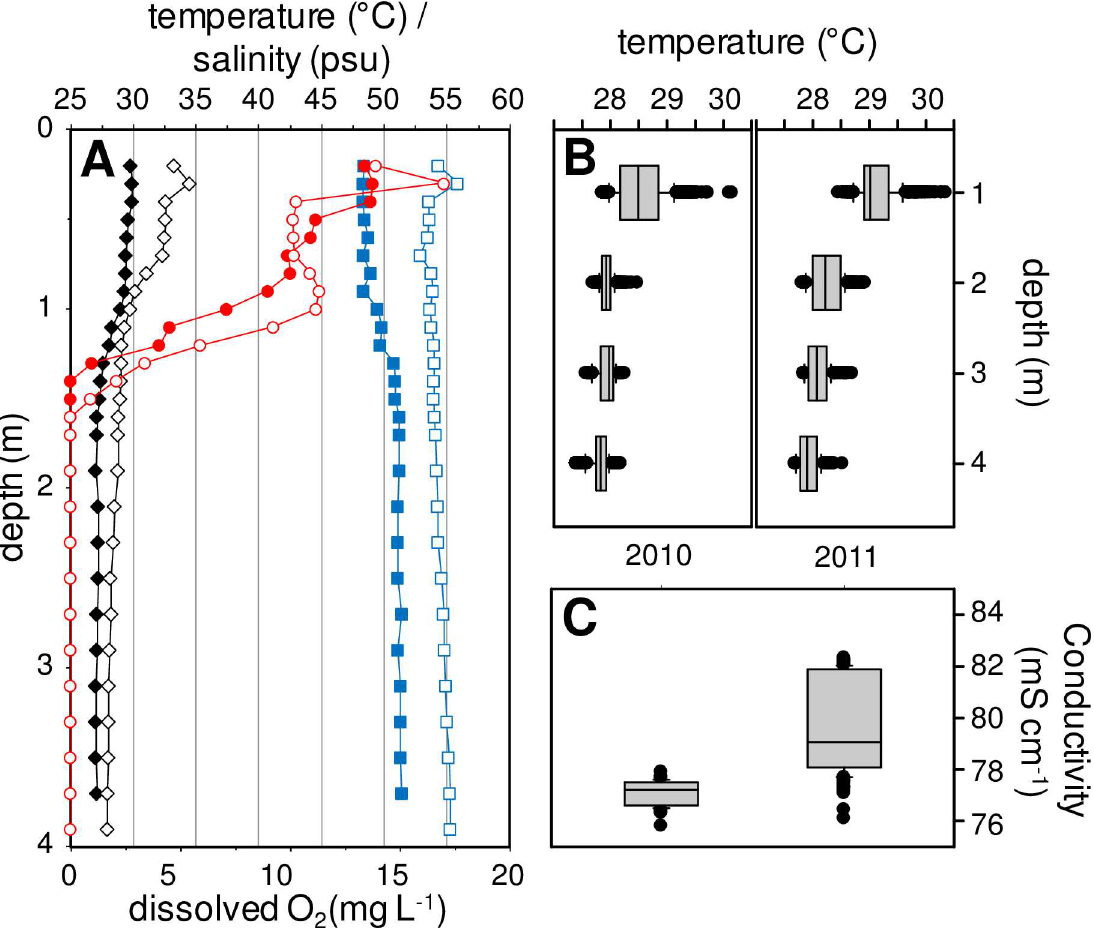
Fig 2. Typical records of vertical profiles. (A) Temperature (˚C, black diamonds),salinity (psu, blue squares) and dissolved oxygen concentration (mg L -1 , red circles) are given for CLB station of Dziani Dzaha Lake in 2010(closed symbols) and 2011 (open symbols). (B) Box-plot of temperature record at four selecteddepths duringthe two surveys (n = 2400). (C) Box-plot of all conductivityrecords duringthe two surveys (n = 370 for 2010; n = 252 for 2011).